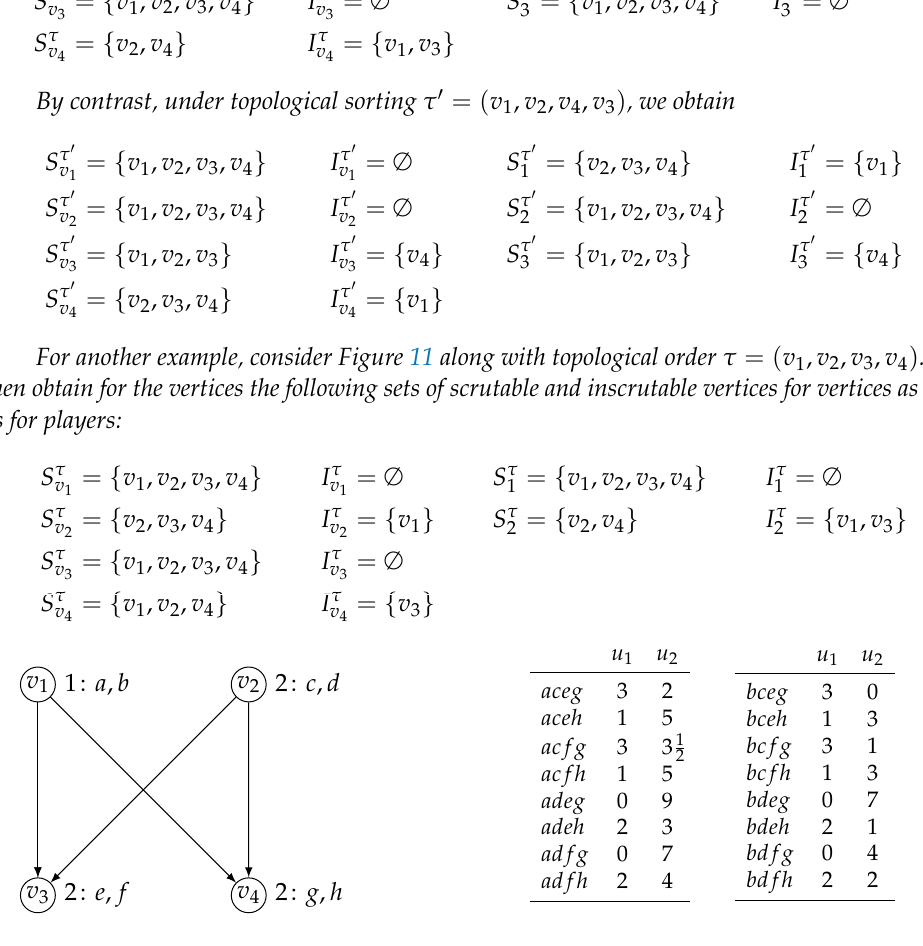
Figure 11. Another example of a partial order